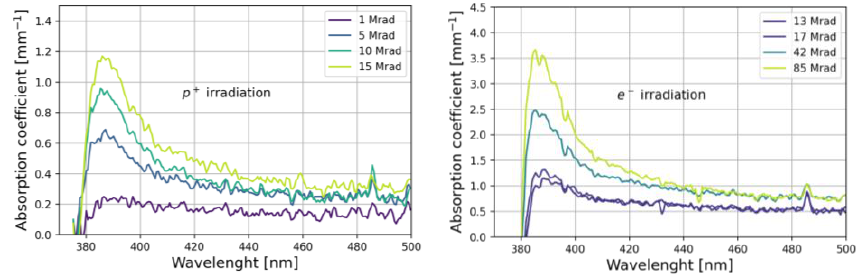
Figure 8. Light transmission spectra for PEN scintillators irradiated with protons ( left ) and electrons ( right ).